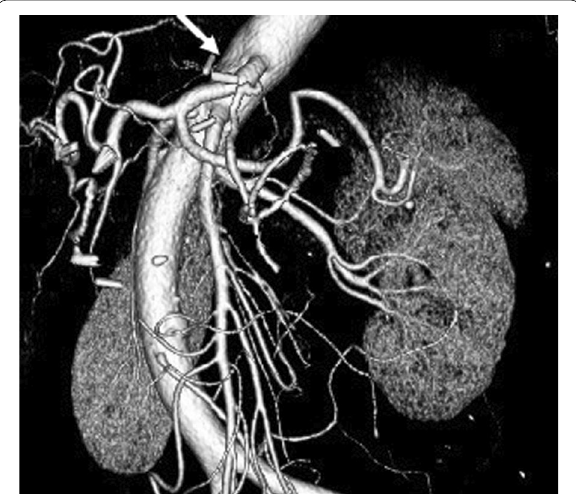
Fig. 4: 3-D CT angiography was performed about 2 months after the operation, and it was confirmed that the stenosis of the celiac artery due to MALS had been resolved